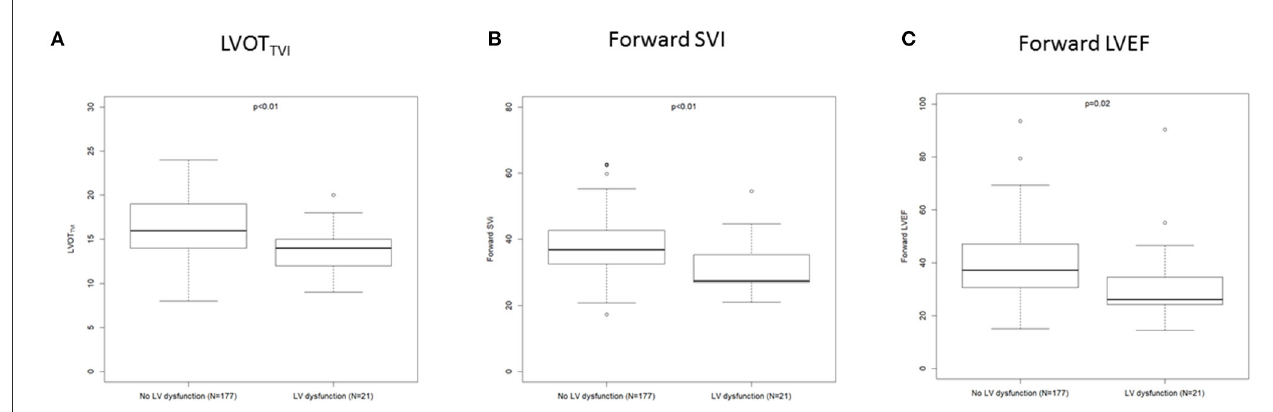
FIGURE1 Box plot showing LVOT TVI (A) , forward SVi (B) , and forward LVEF (C) according to the occurrence of post operative LV